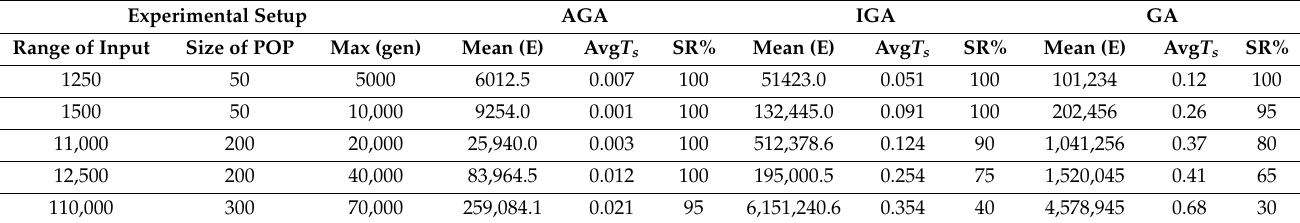
Table 2. Comparative analysis of performance